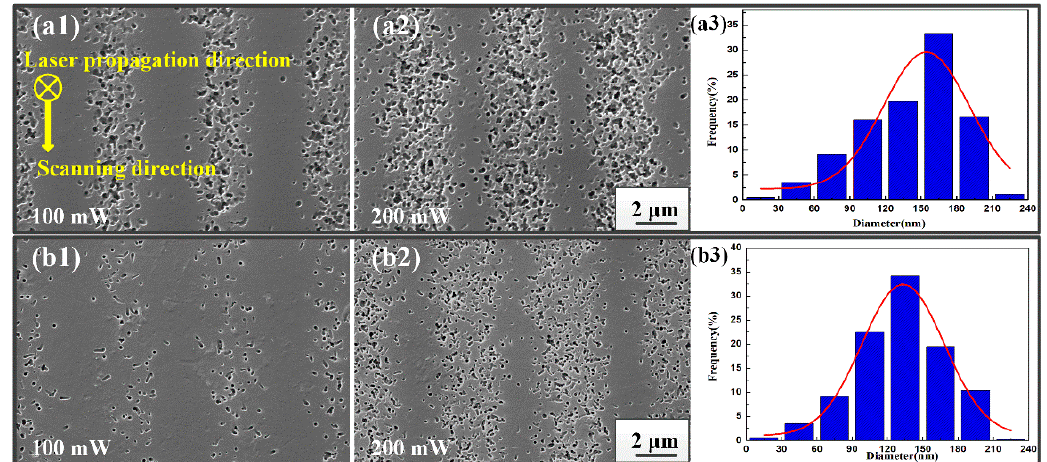
Figure 6. SEM images of nano-crystal formation in PTR glass under different HT times: ( a ) normal time; ( b ) half normal time.